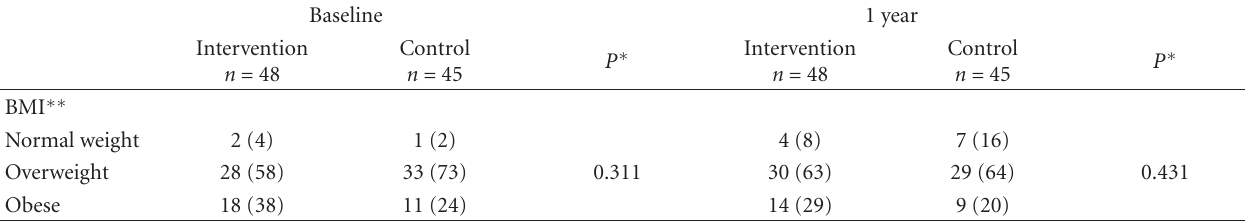
Table 2: Proportion of normal weight, overweight and obesity among overweight, and obese children, presented as number (%). Baseline 1